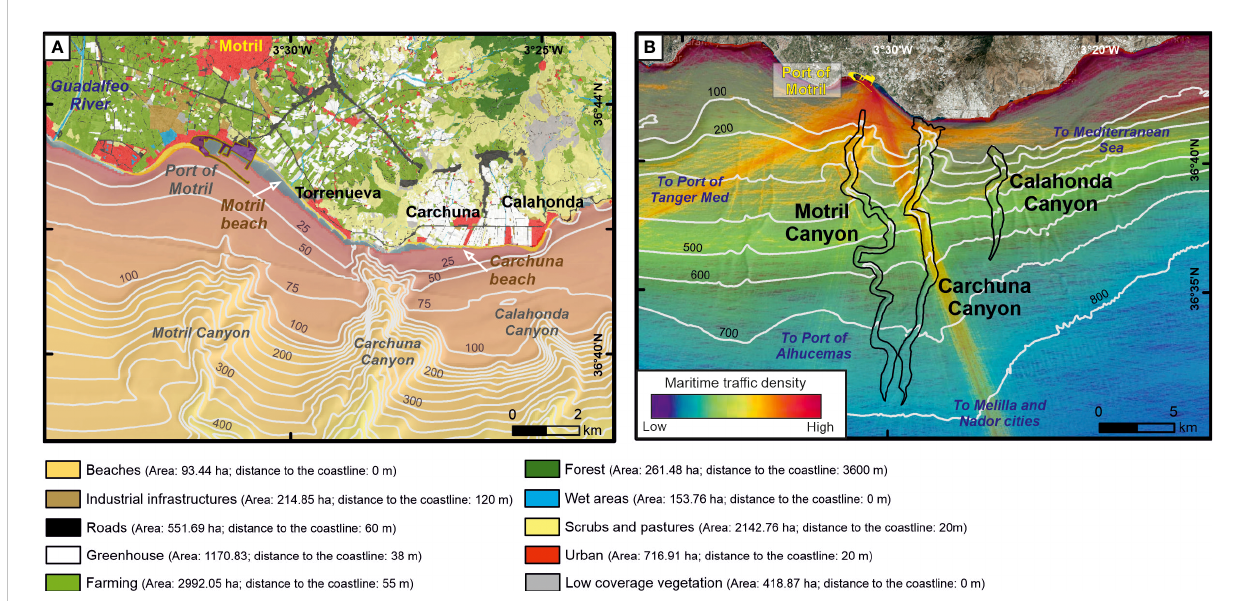
FIGURE 9 Depiction of coastal uses and maritime traf fi c in the study area. (A) Mapping of main land uses in the adjacencies of the three studied submarine canyons ( “ Consejer ı ́ a de Agricultura, Ganader ı ́ a, Pesca y Desarrollo Sostenible, Junta de Andaluc ı ́ a ” , regional government). The area and the minimum distance to the coastline of each land use are shown in the legend. (B) Density (number of routes·0.08 km -2 ·y -1 ) of maritime traf fi c in 2018 (www.marinetraf fi c.com) with the drawing axial channel of the three studied submarine canyons. Bathymetric contours in